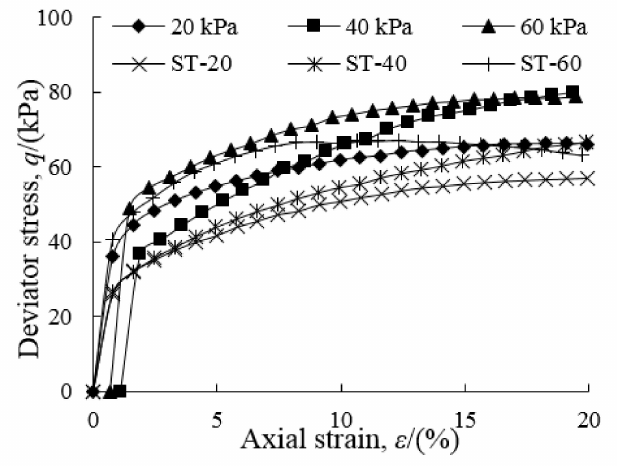
Figure 6. Relationship between axial deviator stress and axial strain of the soft soil with different confining pressures ( n = 1000, CSR = 0.25, U r = 100%).